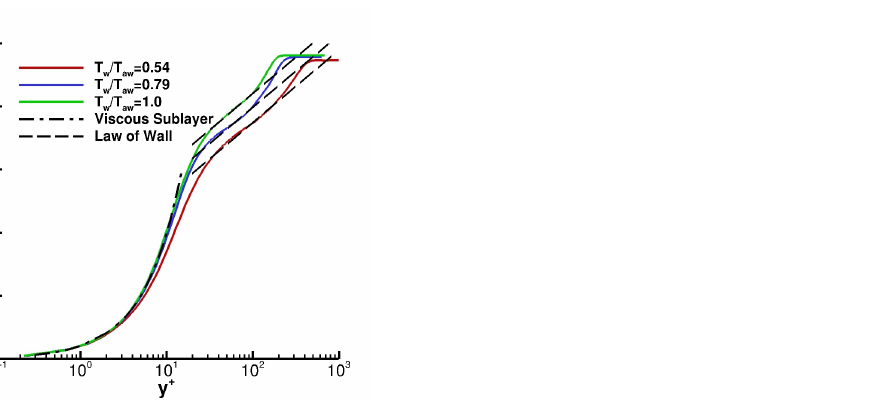
Figure 9. Van Driest transformed mean streamwise velocity for three wall temperature at x / δ = 20 and comparison with the Law of Wall.